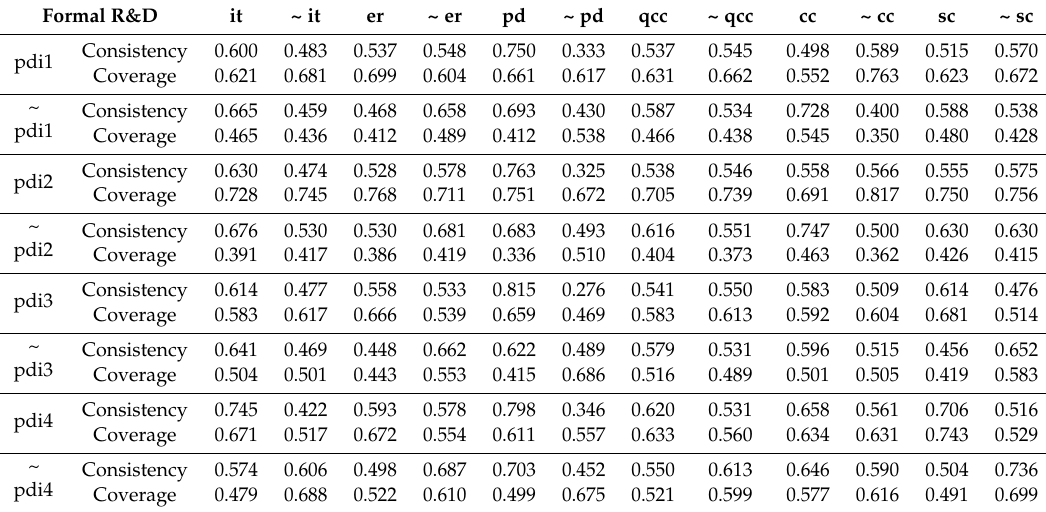
Table 4. Necessity conditions analysis for formal R&D firms.